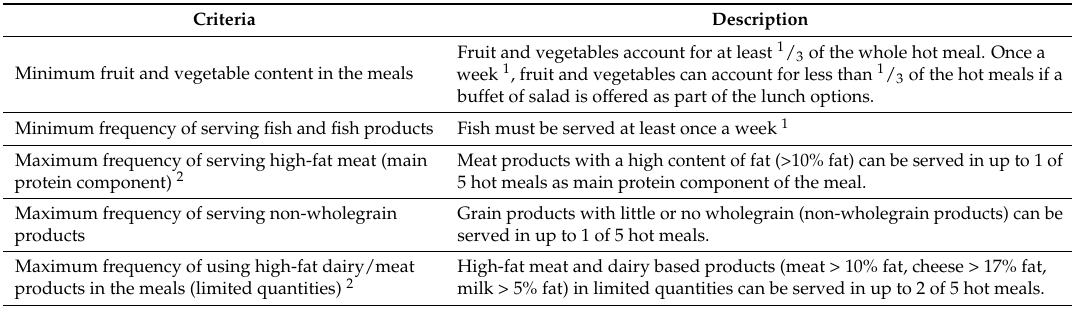
Table 1. Danish food service guidelines for hot meals served at lunch in elementary schools, upper secondary schools and workplaces